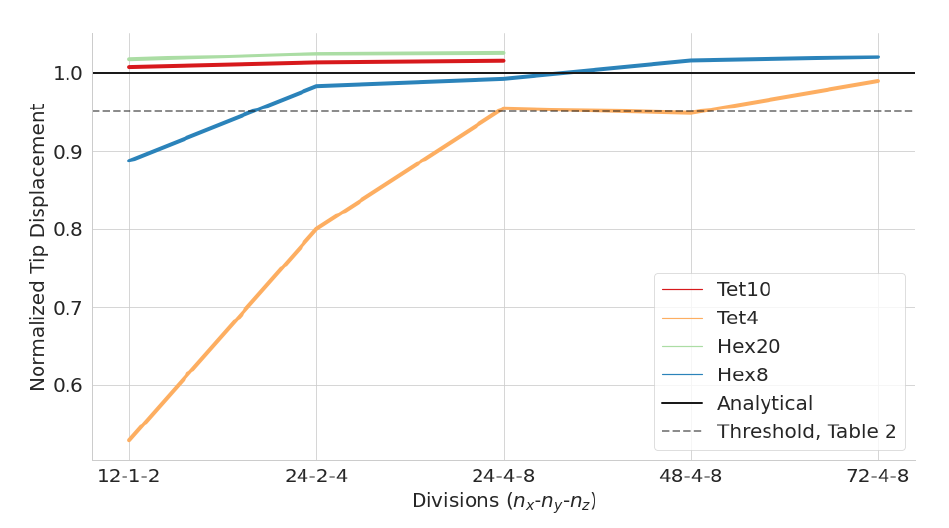
Figure 9. Convergence plot of the available element types for the normalised displacements of the cantilever example. The analytical solution is plottet as a straight line, while the threshold value for Table 2 is